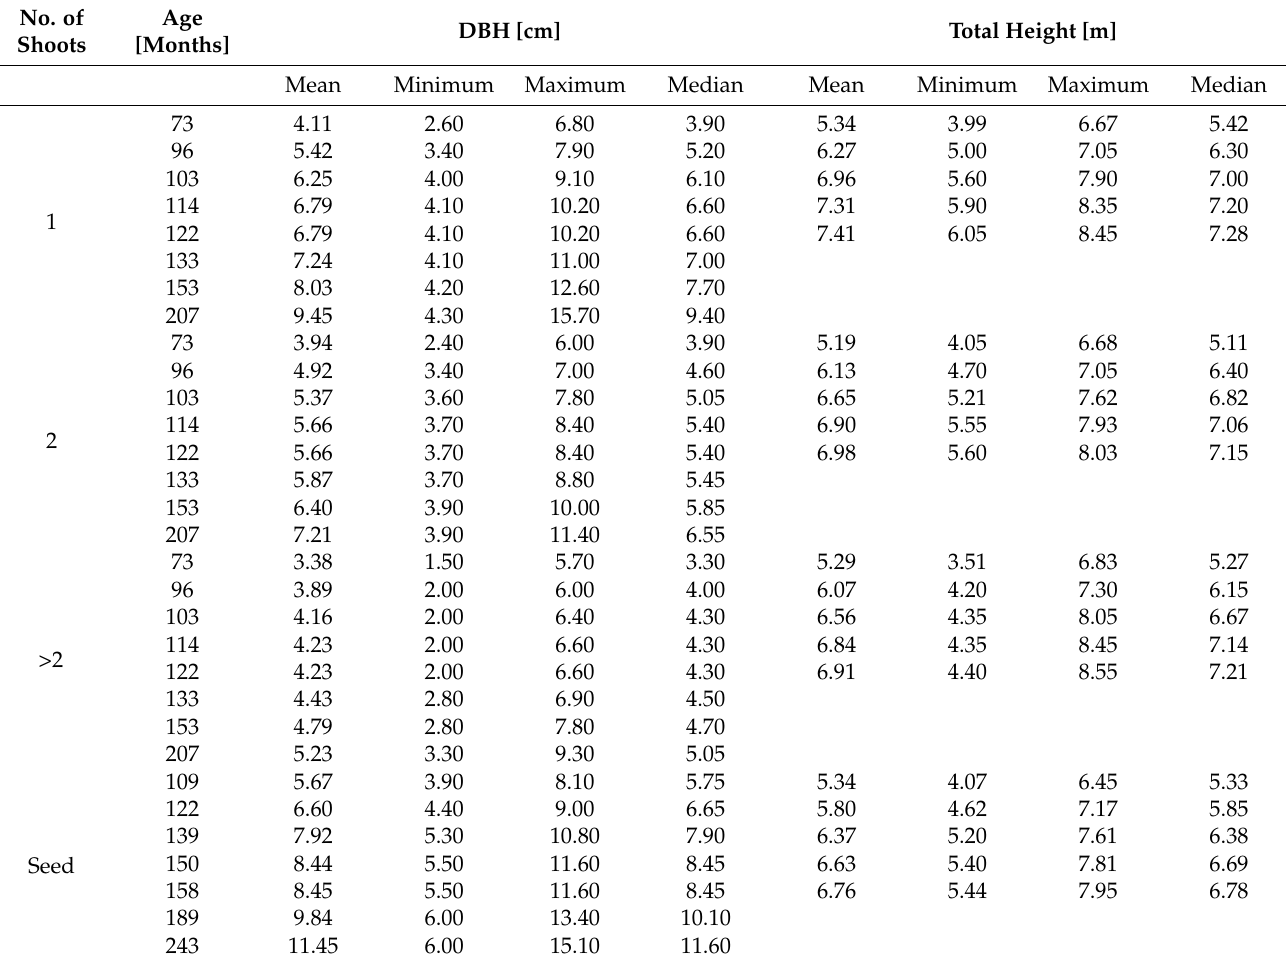
Table 1. Summary statistics describing the change in DBH and height